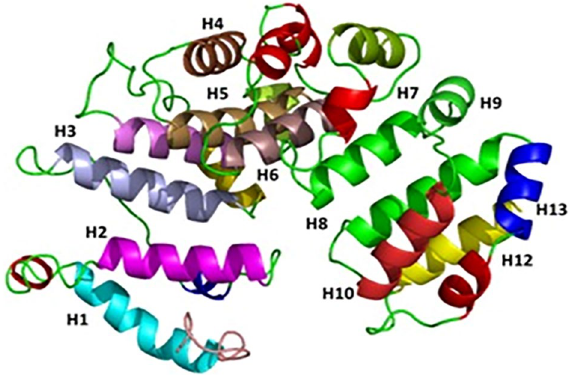
Figure 7. Structural features of GsPUB8 protein from Glycine soja indicating U-box domain with franked